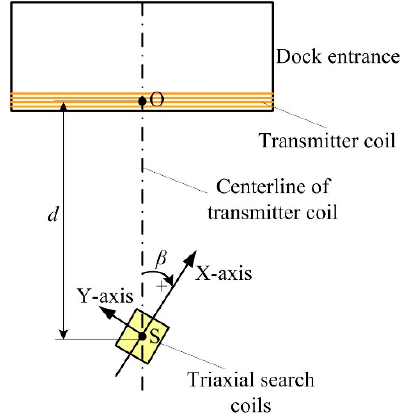
Figure 14. Steady-state performance test setup. The deflection angle β is positive in the clockwise direction. The distance from the center of the triaxial search coils S to the transmitter coil is defined as d .